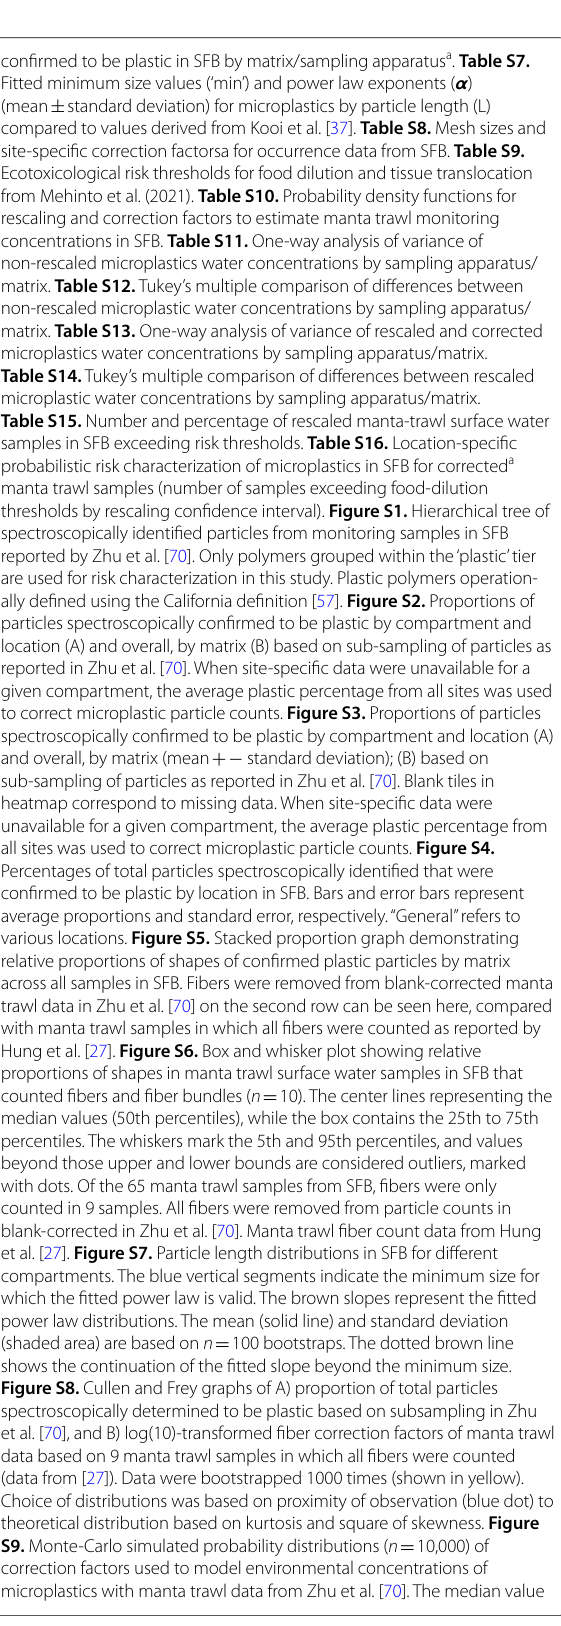
Table S6. Relative particle shape proportions of particles spectroscopically